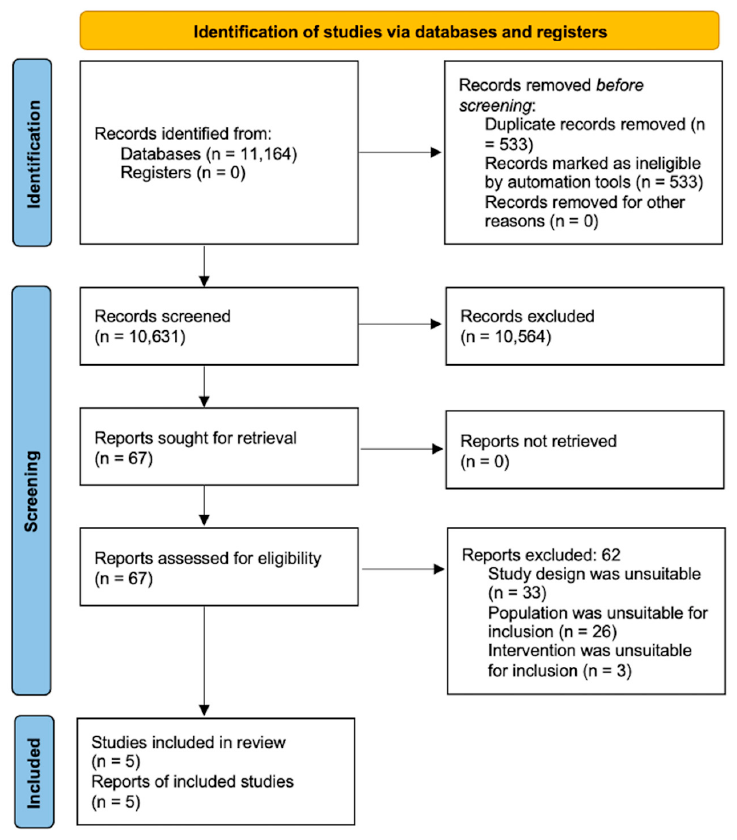
Figure 1. PRISMA study selection [15].